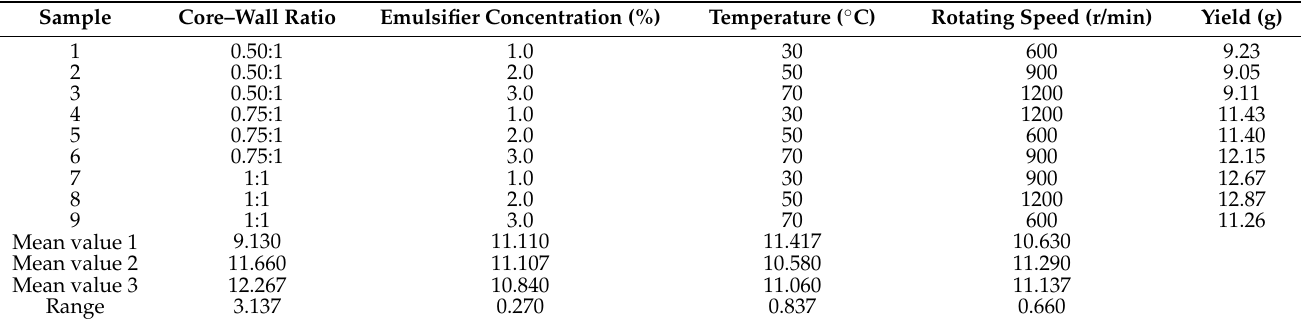
Table 5. Microcapsule yield and range